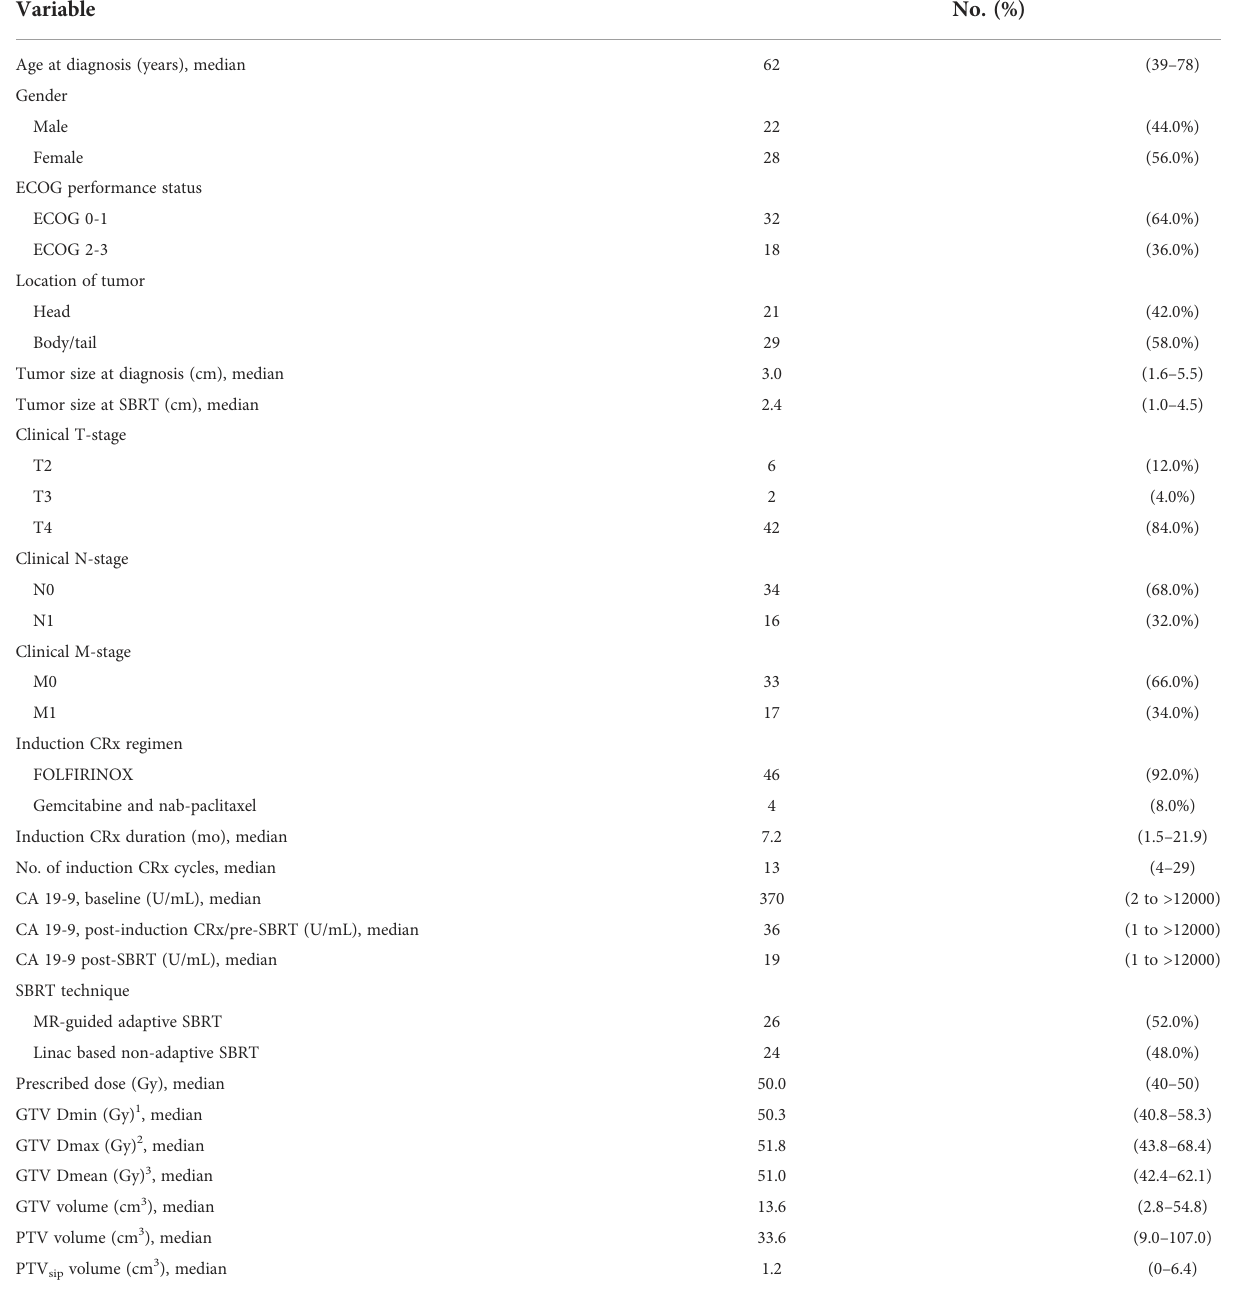
TABLE 1 Patients and treatment characteristics